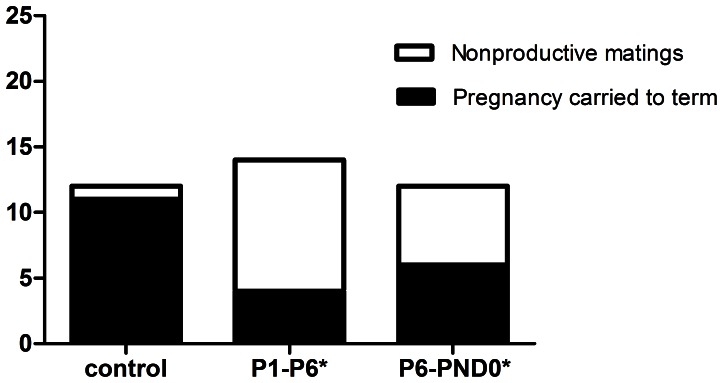
Effects of perinatal exposure to BPA on pregnancy outcomes.Exposure to BPA during preimplantation (P1–P6) or fetal period (P6-PND0) reduced the proportion of pregnancies carried to term. The number of copulations successfully carried to term in each of the groups was recorded via daily visual inspection. Data comparisons were made using Pearson’s chi-square test (*P1–P6: x2 = 10.54, P<0.01; *P6-PND0: x2 = 5.04, P<0.05).